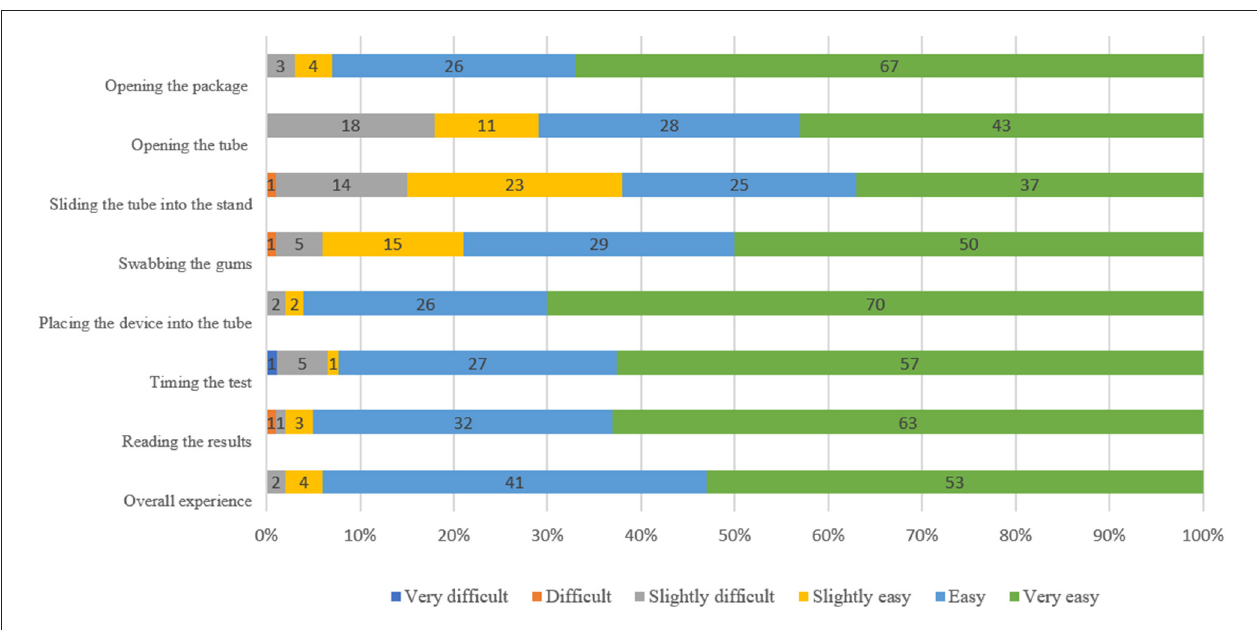
FIGURE 2 | Participants’ perceptions of HCVST usability at different steps among MSM, an observational study in China,